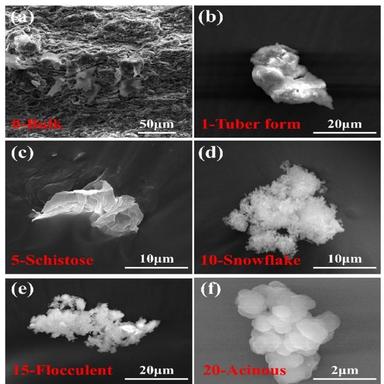
SEM morphology of the oil shale processed via mechanical stripping. (a) SEM image of the bulk oil shale sample without any pretreatment. (b)e(f) SEM images of kerogen stripped using tape strips 1, 5, 10, 15, and 20, respectively.